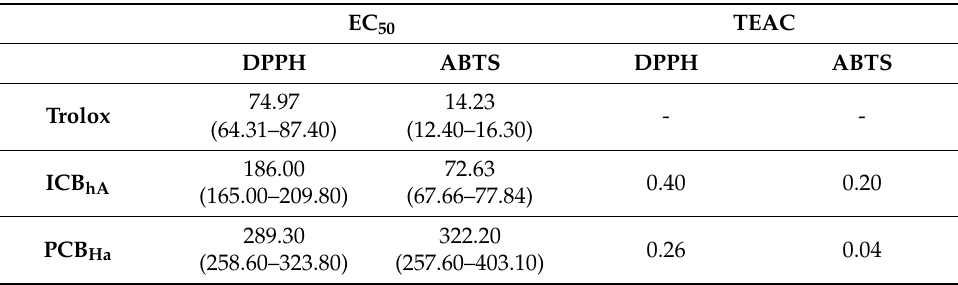
Table 1. 2,2-Diphenyl-1-picrylhydrazyl (DPPH) and 2 (cid:48) -azino-bis (3-ethylbenzothiazoline-6-sulfonic acid) diammonium salt (ABTS) assays, concentration of samples to scavenge the ABTS + of 50% (EC 50 ) and Trolox Equivalent Antioxidant Capacity (TEAC) values. EC 50 values ( µ g/mL) with confidence limits (95%, in brackets) and TEAC values (EC 50 Trolox/EC 50 Sample) of hydroalcoholic extracts of Indonesian cocoa beans (ICB) and Peruvian cocoa beans (PCB) samples in DPPH and ABTS assays. Trolox was used as